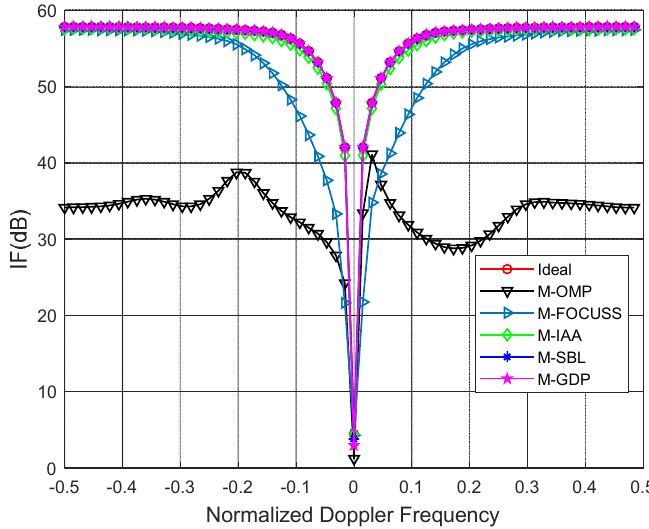
8 of 13 Table 2. Simulation parameters of the radar system. Parameters Values Number of elements in array 8 Number of pulses per CPI 8 Pulse repetition frequency Receiver bandwidth 2000 Hz 2.5 MHz Platform height 9000 m Wavelength Platform velocity Platform acceleration Operation frequency 0.3 m 150 m/s 50 1 Ghz In order to evaluate the clutter suppression performance of the proposed method, we used the metric of improvement factor (IF), which is a widely used indicator to as- sess the performance of our proposed method and other reference methods, defined as follows: w s w Rw (27) The proposed method is compared with the multiple orthogonal matching pursuit (M-OMP-STAP), the multiple focal underdetermined system solver (M-FOCUSS-STAP), and the iterative adaptive approach (IAA-STAP). In addition, we also added the tradi- tional STAP algorithm based on the angle Doppler compensation (ADC-STAP) for com- parison. Figures 2 and 3 plot the IF versus the normalized Doppler frequency curves under ideal and non-ideal conditions, respectively. For the non-ideal condition, we add-